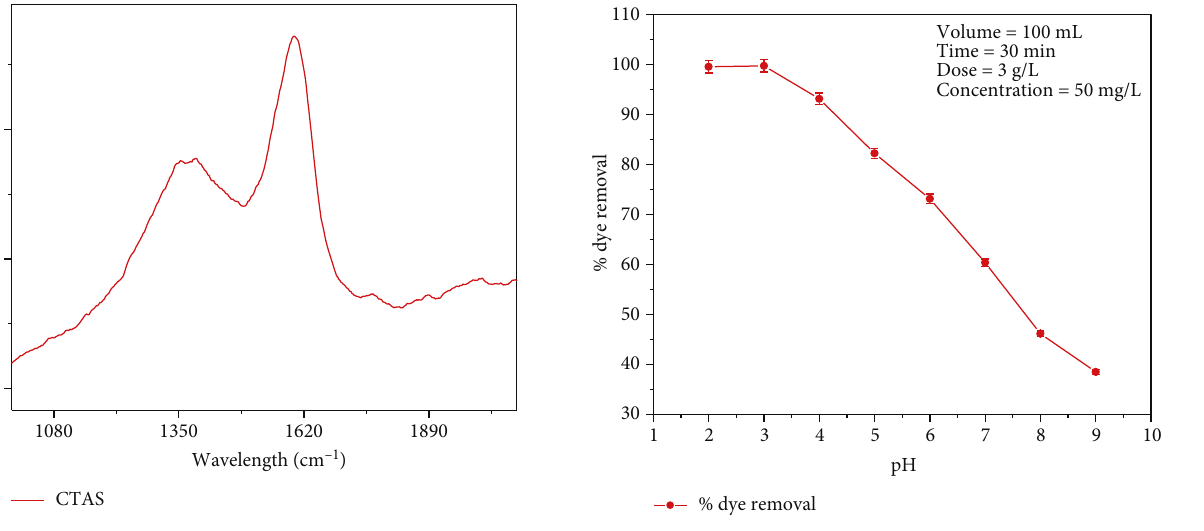
Figure 8: E ff ect of pH on ARS dye